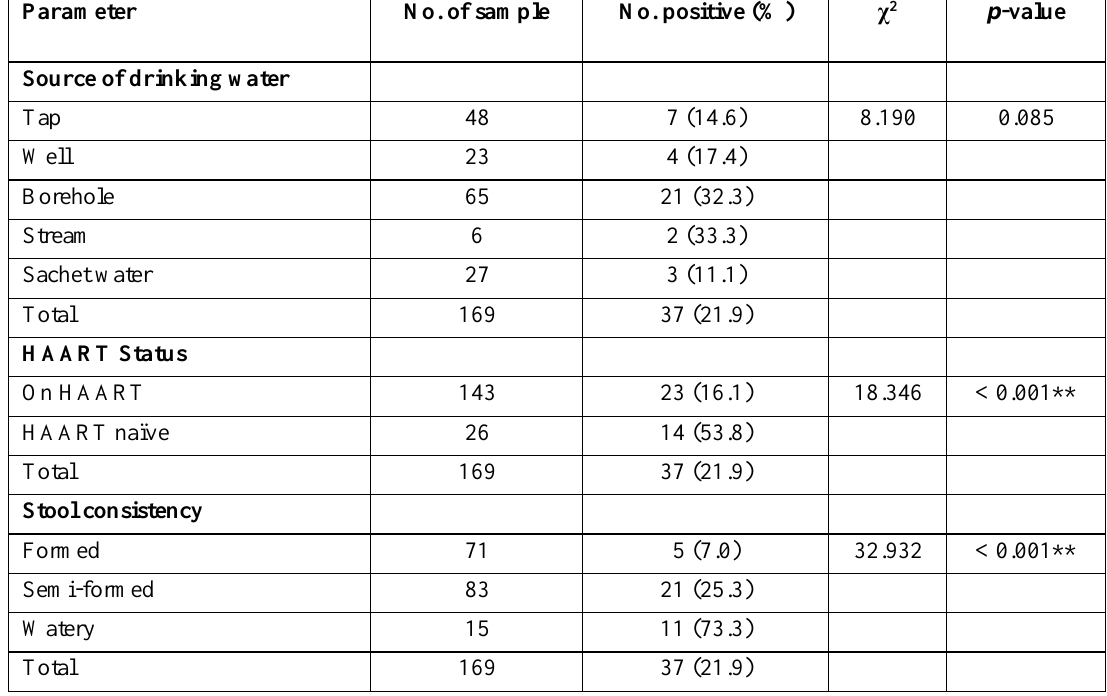
Table 2. Prevalence of intestinal helminths according to risk factors and symptoms of HIV patients attending Faith Alive Foundation, Jos.